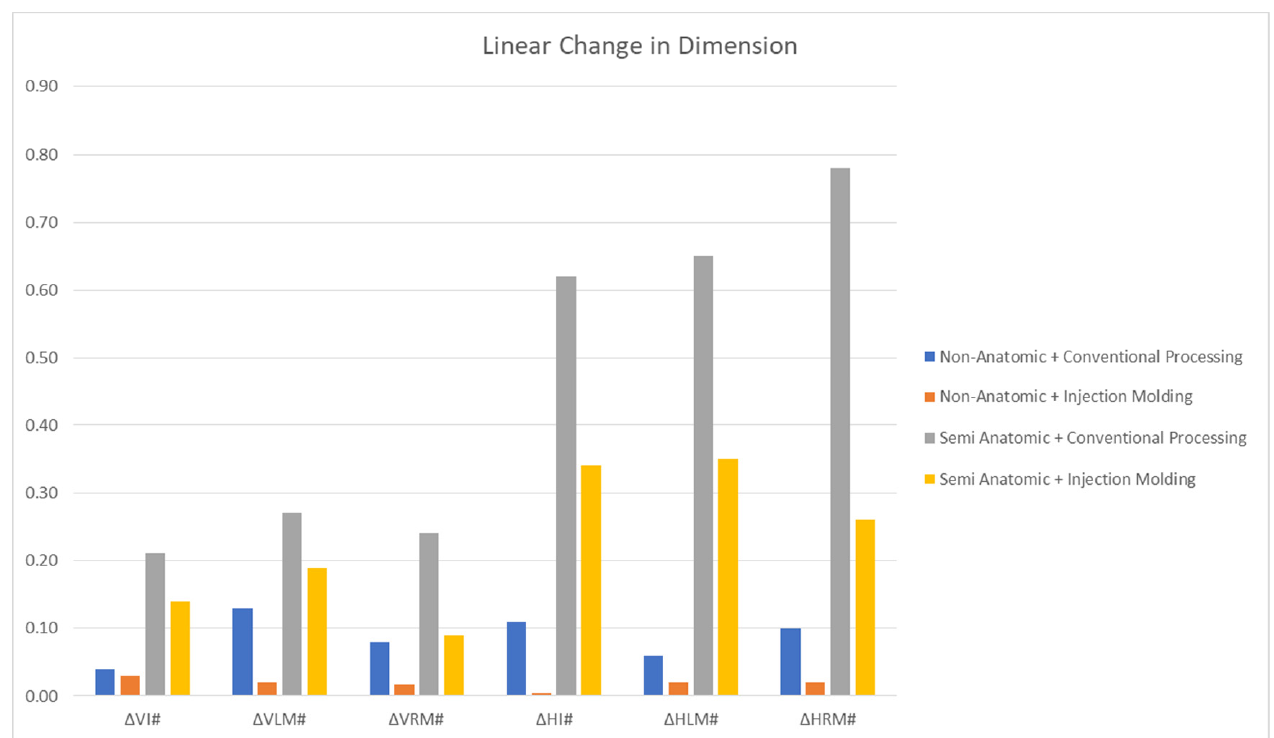
The mean linear dimensional changes among the groups are presented in Table 2 and Figure 4. The maximum linear dimensional changes in the positions of the molar in the vertical direction were observed in complete dentures with semi-anatomic teeth and that were processed using the conventional compression molding technique (0.27 ± 0.46 and 0.24 ± 0.61). The smallest changes were observed in complete dentures with non-anatomic teeth and that were processed using the injection molding technique (0.02 ± 0.59 and 0.017 ± 0.75). The maximum linear dimensional changes in the positions of the incisor in the vertical direction were observed in complete dentures with semi-anatomic teeth and that were processed using the conventional compression molding technique (0.21 ± 0.89), whereas complete dentures with non-anatomic teeth that were processed using the injection molding technique showed the smallest changes (0.03 ± 0.44).